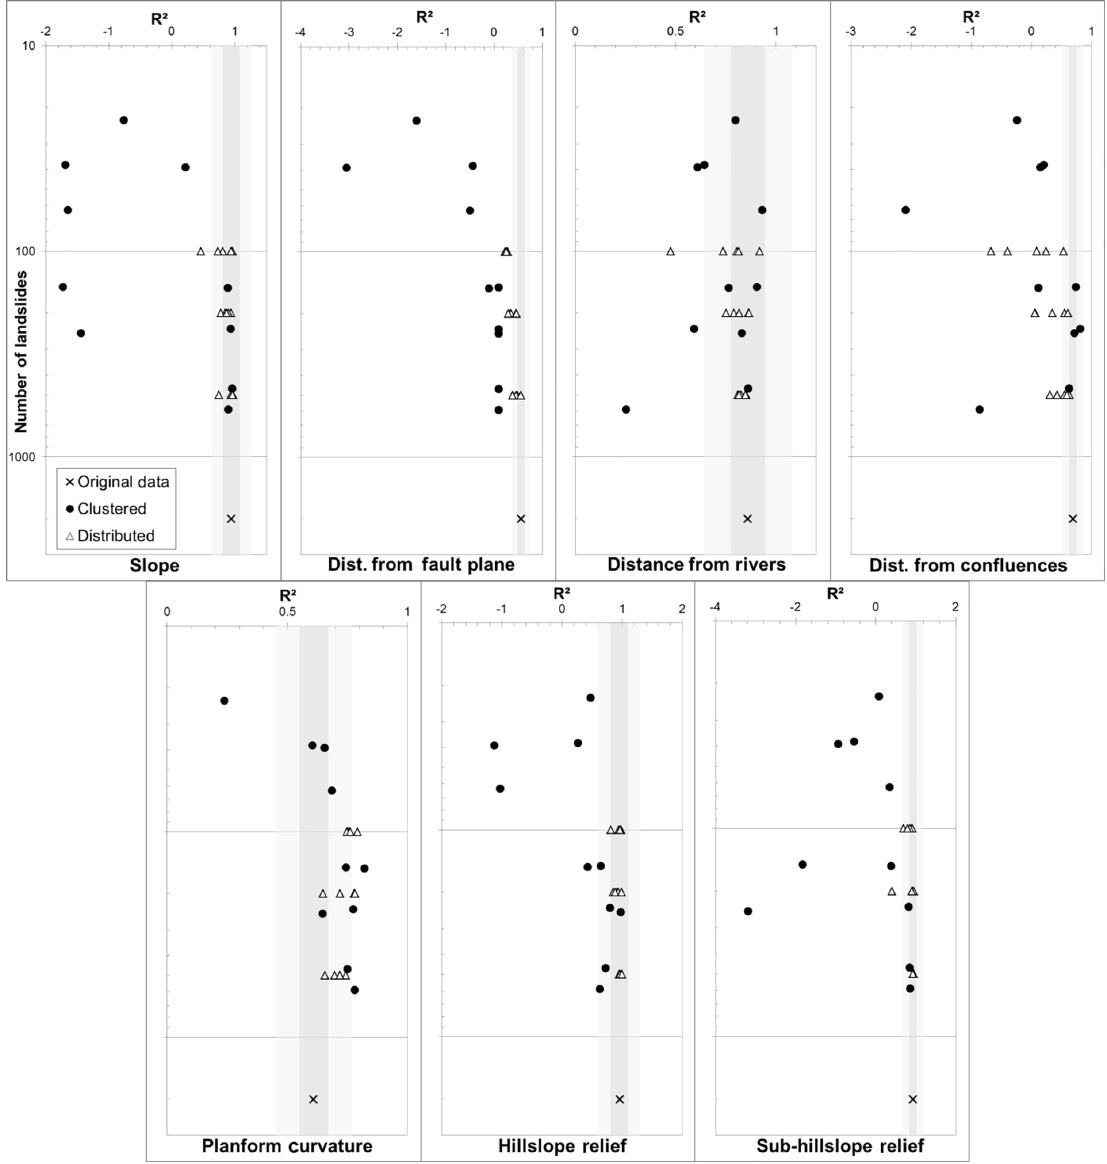
Figure 8. Effect of using smaller subsampled landslide inventories, either clustered or distributed across the entire affected area, on an R 2 fit of membership curves for different predisposing factors (Fig. 3). The dark grey box shows values within 10% of the original R 2 value; the light grey box shows values within 25% of the original R 2